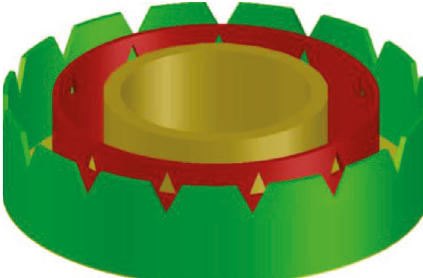
Figure 1: The new choke structure proposed in this paper.